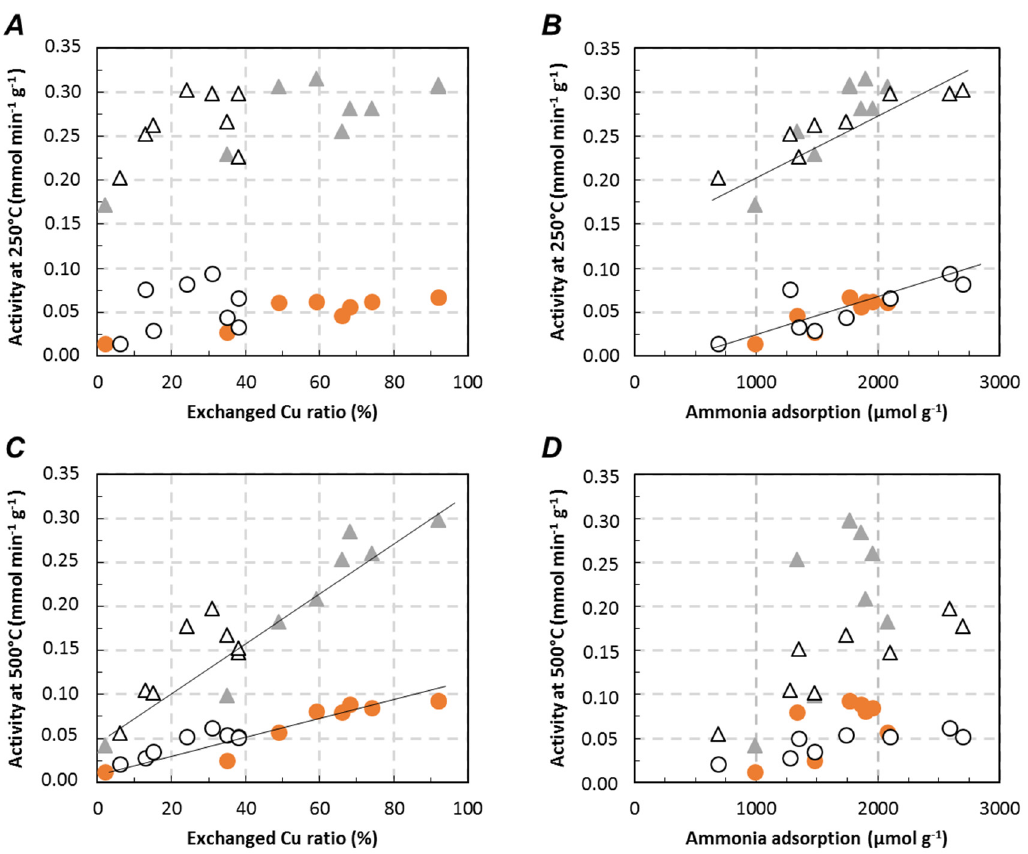
Figure 1. NO x conversion by NH 3 over Cu/FER-exchanged zeolite. ( A ) standard-SCR; ( B ) Fast-SCR. ( — , ): Cu 2.8 /FER; ( — , ): Cu 6.1 /FER. Figure 10. Effect of copper content of Cu 2.8 /FER ( , ) and Cu 6.1 /FER ( , ) catalysts in the relationship between deNOx activity in Standard ‐ SCR ( ) and Fast ‐ SCR ( ) and exchanged Cu (( A ) 250 °C; ( C ) 500 °C) or ammonia adsorption (( B ) 250 °C, ( D ) 500 °C).